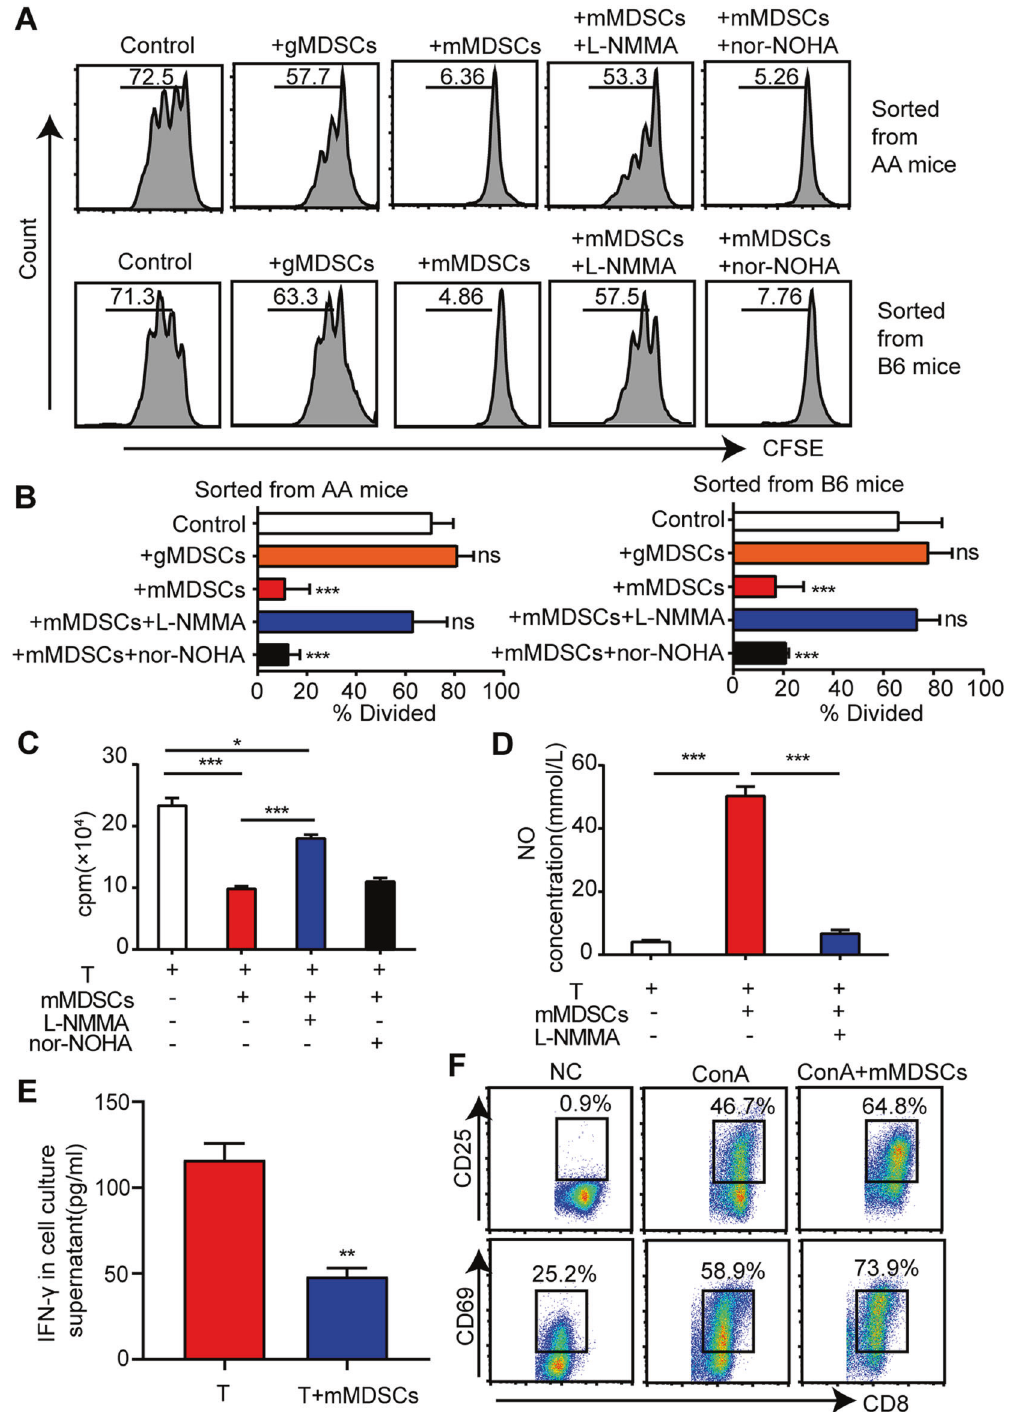
Fig. 4 The effect of mMDSCs on T cell proliferation and IFN- γ secretion in vitro. A , B CFSE-labeled CD8 + T cells were activated with ConA (5 μ g/mL) for 72 h, and cocultured with AA-BM derived mMDSC or gMDSC at the ratio of 1:1. Induced NOS inhibitor L-NMMA (2 μ g/mL) and Arg-1 inhibitor nor-NOHA (2 μ g/mL) were added in the culture system. A Data were collected from BM cells of AA mice or healthy B6 mice, with representative FACs analyses. B Histograms represented the percentages of CD8 + T cells that divided into different treatment groups. Data represent mean±SEM in three independent experiments. *** P < 0.001. C The numbers of CD8 + T cells in co-culture system were counted by fl ow cytometer at the same in- fl ux rate per minute, with or without mMDSCs, or with mMDSCs and L-NMMA/nor-NOHA. Data represent mean ± SEM in three independent experiments. * P < 0.05, *** P < 0.001. D The NO concentration in the supernatants of ConA-stimulated T cells cocultured with mMDSCs (1:1), in the presence or absence of L-NMMA (2 μ g/mL). Data represent mean ± SEM in three independent experiments. *** P < 0.001. E ConA-stimulated CD8 + T cells were cultured alone or co-cultured with mMDSCs at the ratio of 1:1 for 72 h. The concentrations of IFN- γ in the supernatants were determined. Data represent mean±SEM in three independent experiments. ** P < 0.01. F FACs analysis of T cell activated makers, CD25 and CD69 on ConA-stimulated CD8 + T cells cocultured with or without AA-BM derived mMDSCs for 72 h. Cell Death and Disease (2022)